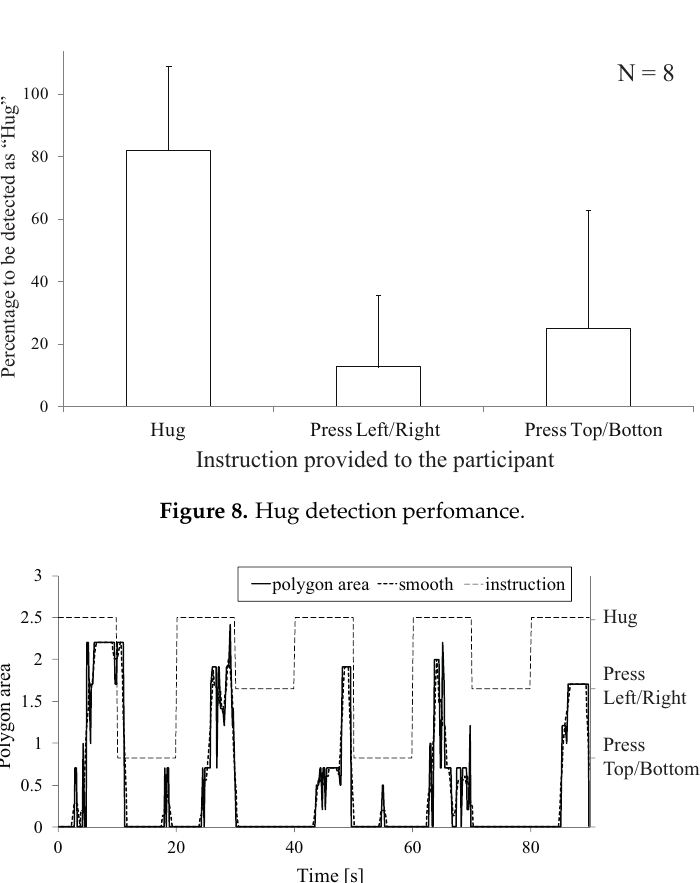
Figure 9. Data from one participant’s session. The peaks of the dotted line represent the intervals when the hug instruction was